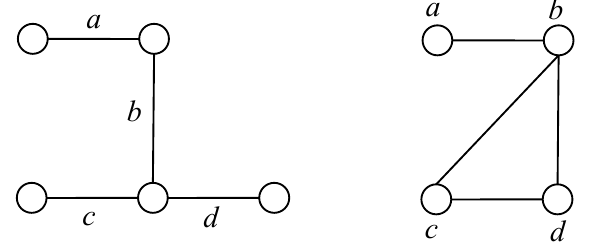
Figure 7. A graph G ( left ) with its line graph L ( G ) ( right